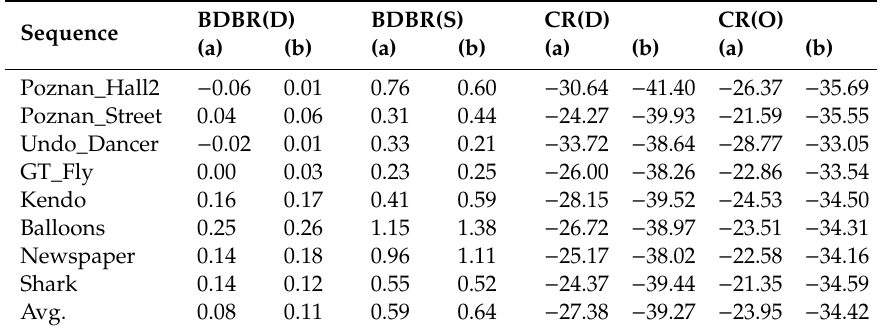
Table 4. Overall performance of (a) the FHEVCI + ADMMS method and (b) the proposed method. Sequence